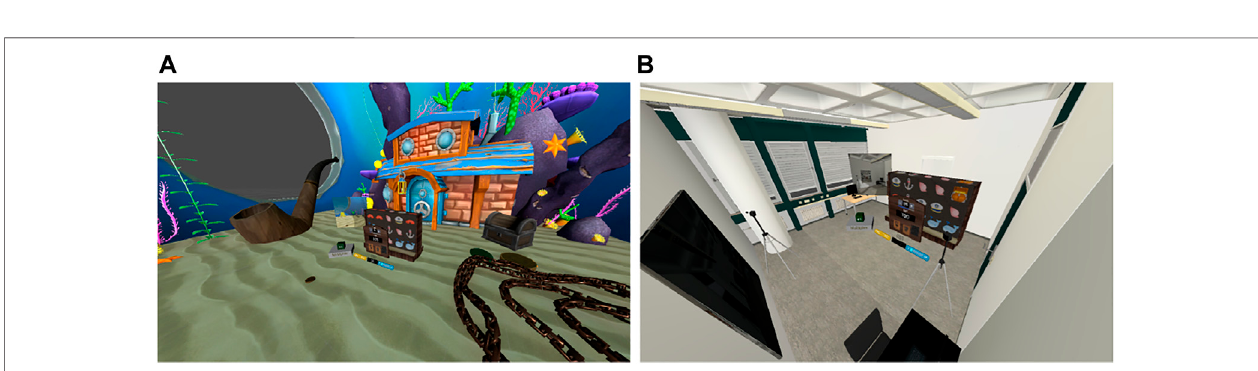
FIGURE 7 | We embedded the slot machine in two VEs to investigate their in fl uence on the gambling behavior. The (A) screenshot shows the playground environment and the (B) screenshot the lab environment.